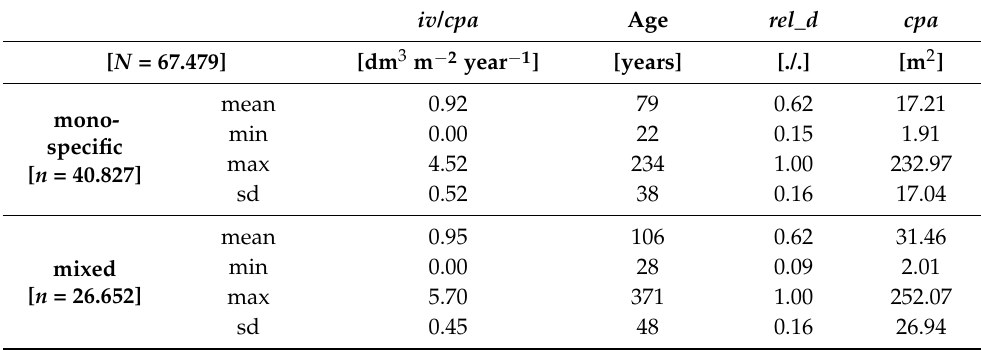
Table 3. Tree data; iv/cpa —single tree productivity; Age—age (oak); rel_d —relative dbh (social class); cpa —crown projection area; shown are mean, min, max and sd values for monospecific and mixed oak stands; N and n —number of